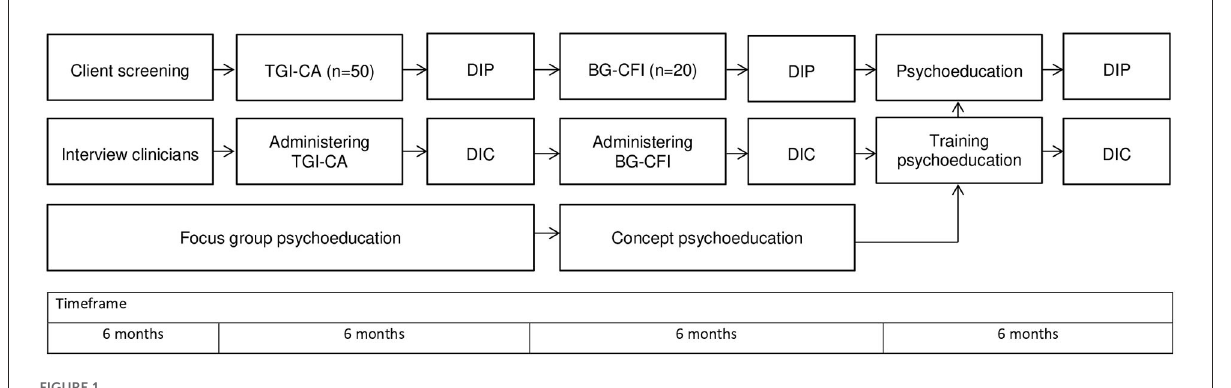
FIGURE1 Procedure let’s talk about grief study.